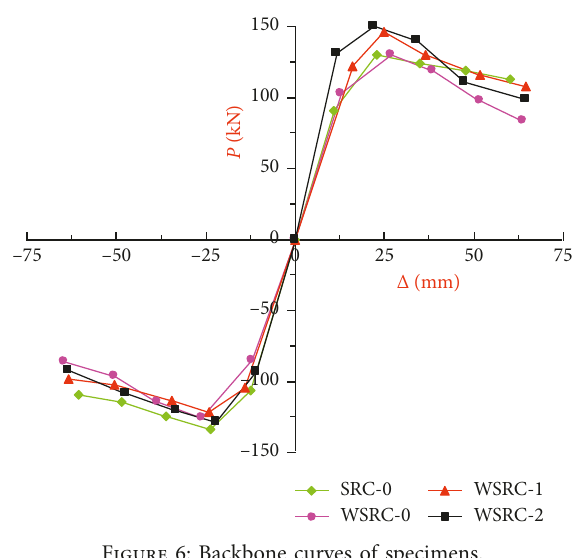
Figure 6: Backbone curves of